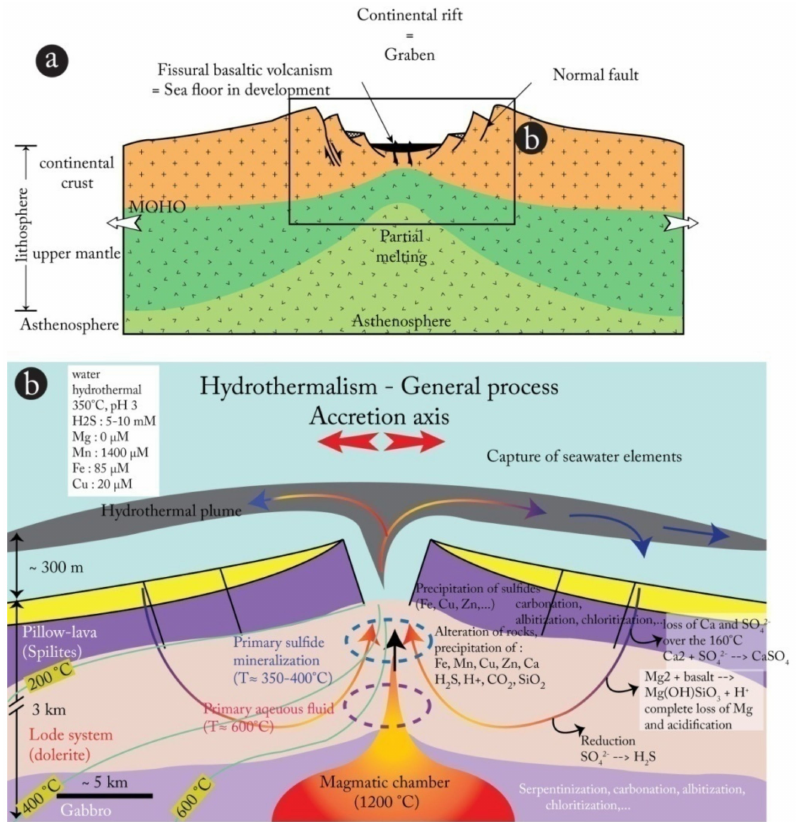
Figure 24. Proposed genetic implementation model for primary sulfide mineralization at the NNE-A sector ( a , b )